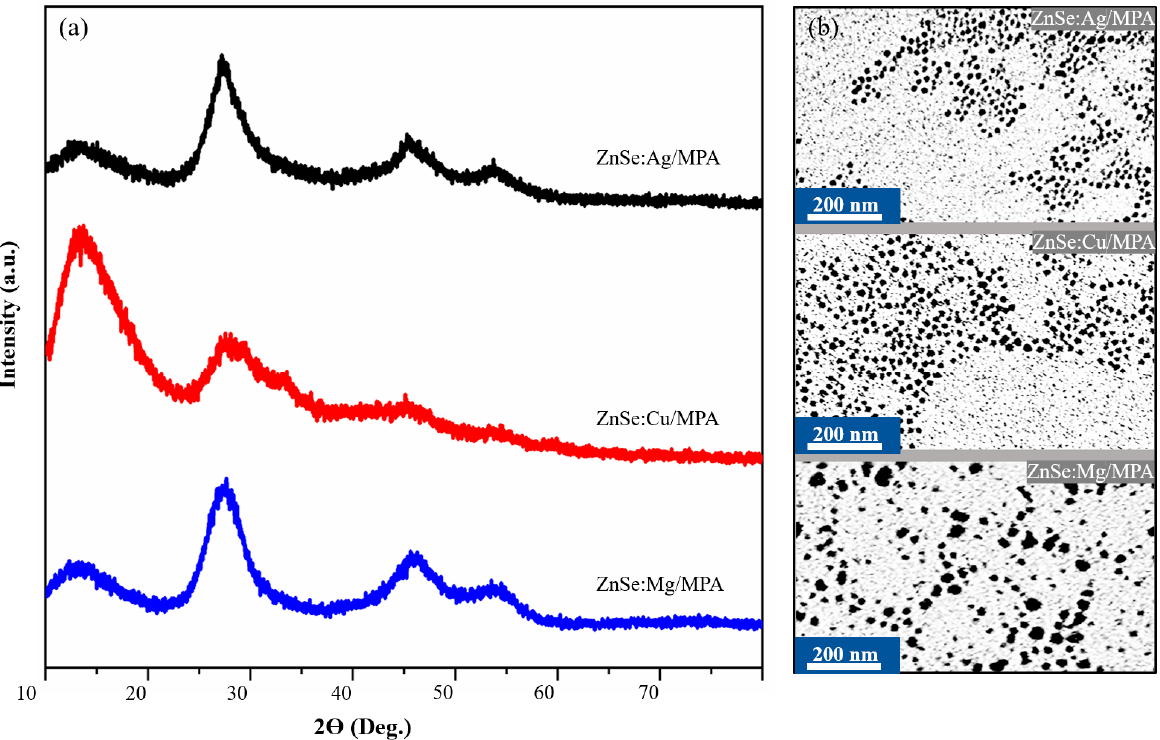
Figure 2. ( a ) The XRD patterns, and ( b ) TEM images of ZnSe:X (1%) at various dopants (Ag, Cu, and Mg). However, the PL behavior depends on the addition of lysine (Figure 4). Obviously, the fluorescence intensity increases significantly with an increase in the lysine